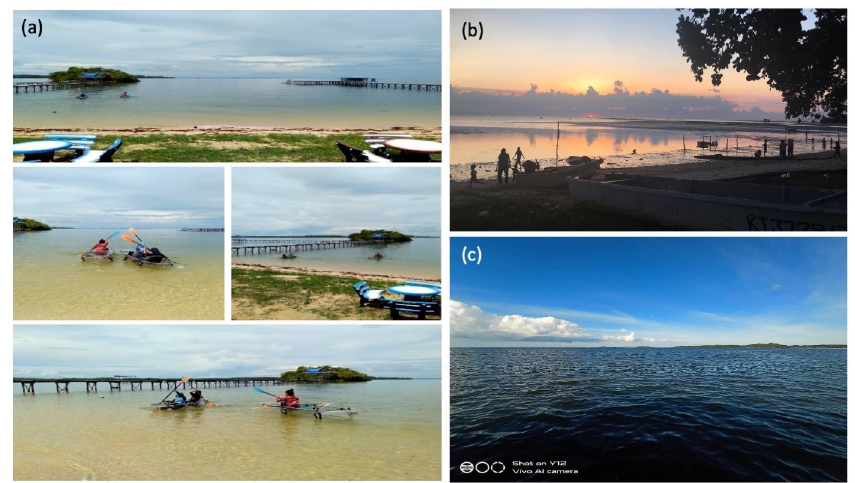
Fig 7. Photographs portraying economic aspects of participants’ life at Malubang village associated with cultural and provisioning services. (a) This collage shows a shore that was a destination for tourists to do recreational activities, hence providing business opportunities for villagers. (b) This shore was a destination for tourists and villagers to do recreational activities such as swimming and photography besides being source of seafood. (c) This sea near Malubang was a source of livelihood for villagers as they fish